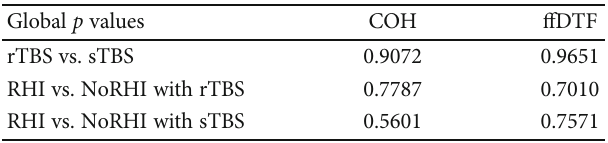
Figure 2: Four sessions with one week interval. EPT: electrical perception test; rTBS: real theta burst stimulation; sTBS: sham theta burst stimulation; rRHI: real rubber hand illusion; sRHI: sham rubber hand illusion. Table 1: Global p values for the three comparisons for COH and ff